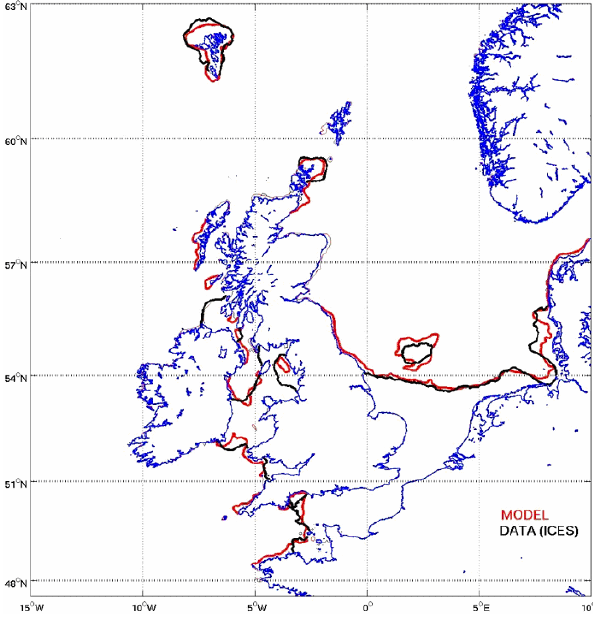
Fig. 10. Summer (June, July, August) tidal front positions as Figure 10: Summer (June, July, August) tidal fronts positions as deduced from surface to bottom deduced from surface to bottom temperature difference ( 1T = temperature difference ( ∆ T=0.5°C) from the model (red) and from ICES data (black). 0 . 5 ◦ C) from the model (red) and from ICES data